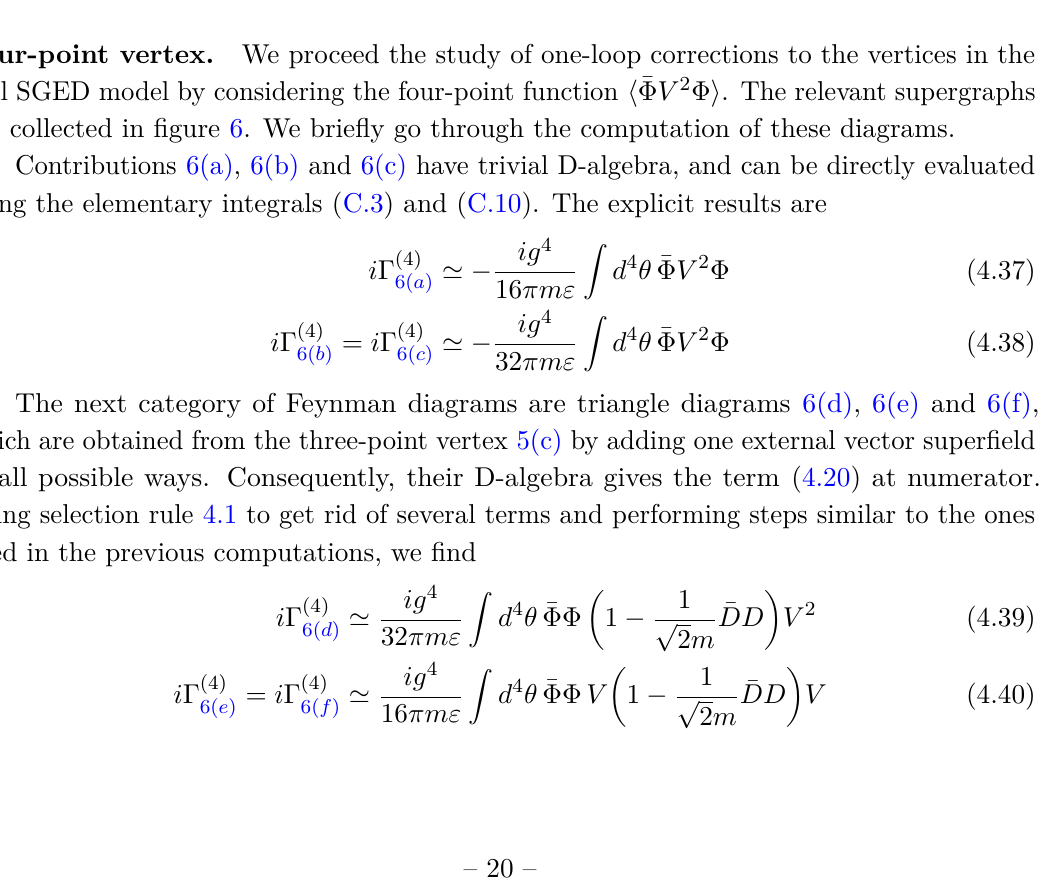
Figure 6 . One-loop diagrams contributing to the quantum corrections of the four-point vertex ¯Φ h V 2 Φ i . The graphs (b), (c) and the graphs (e), (f) are mapped into each other by reversing the arrows along the chiral